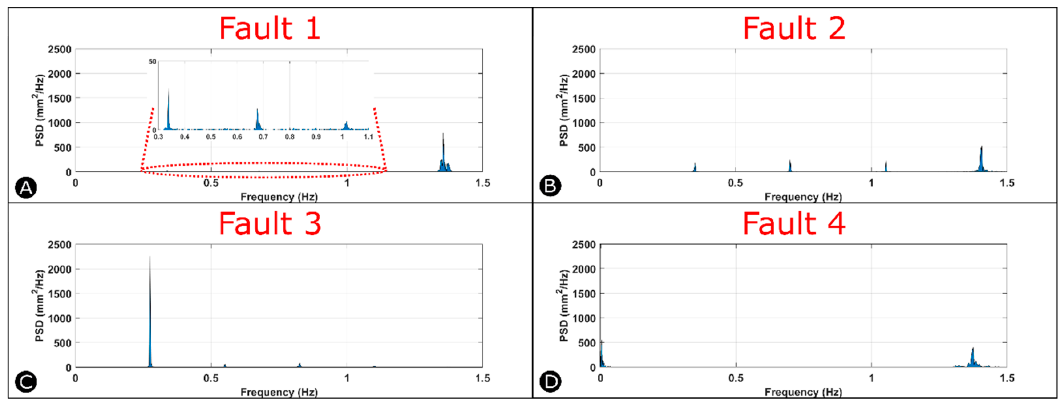
Figure 6. Spectral analysis of the data after introducing ( A ) Fault 1, ( B ) Fault 2, ( C ) Fault 3 and ( D ) Fault 4 to the system.